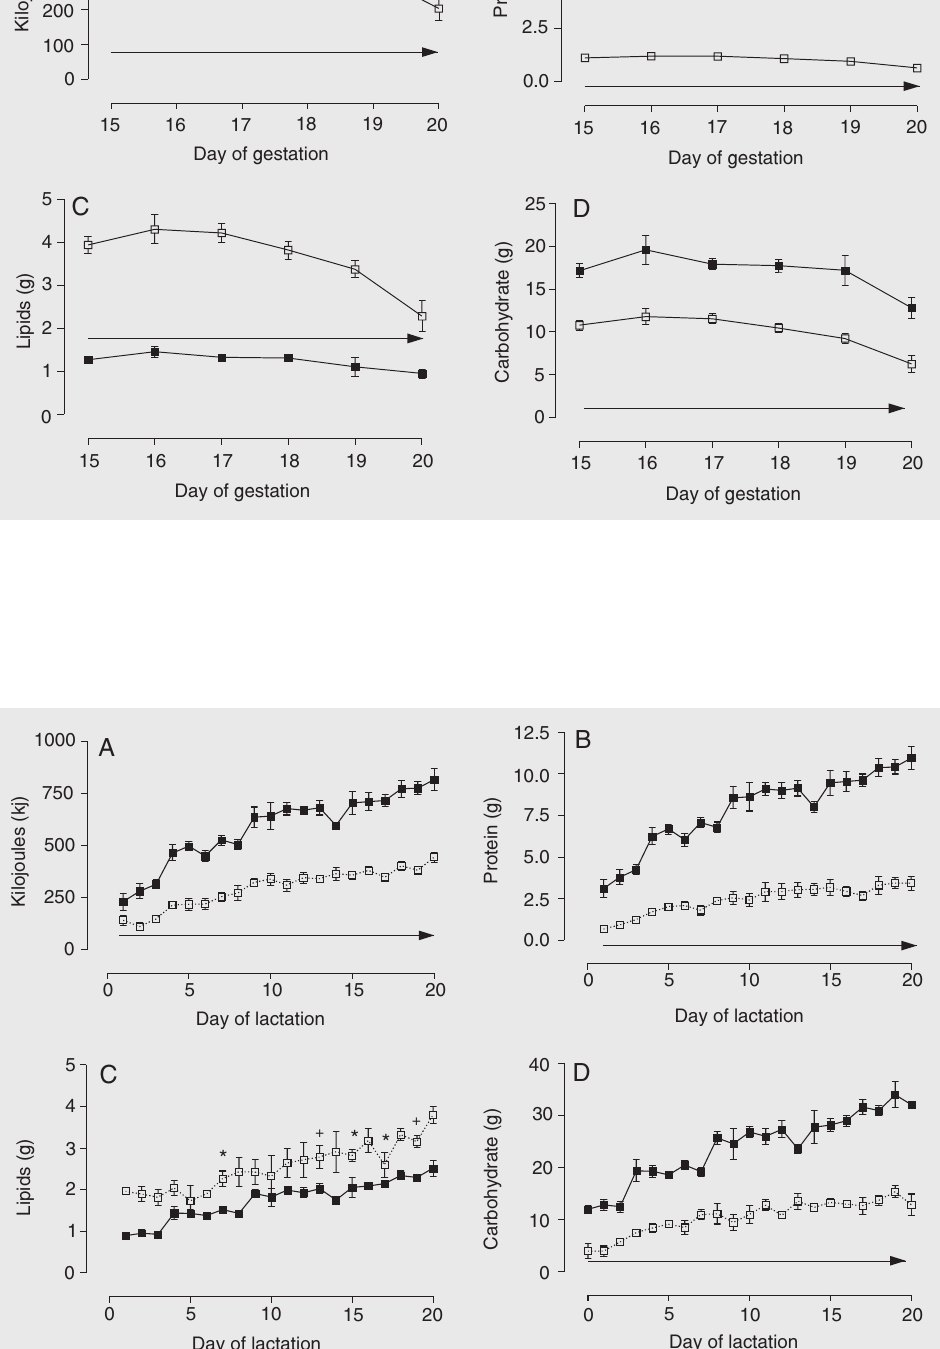
Figure 2. Energy (A), protein (B), lipid (C), and carbohydrate (D) intake by control dams (filled squares) and dams receiving a high-fat and low-protein diet (open squares) during gestation. The comparison was made for each day and the arrow indi- cates that the significance oc- curred during all the period. Data are reported as means ± SEM for 8 animals per group. A , F = 32.3 for diet and 8.3 for time (P < 0.0001, two-way ANOVA; P <